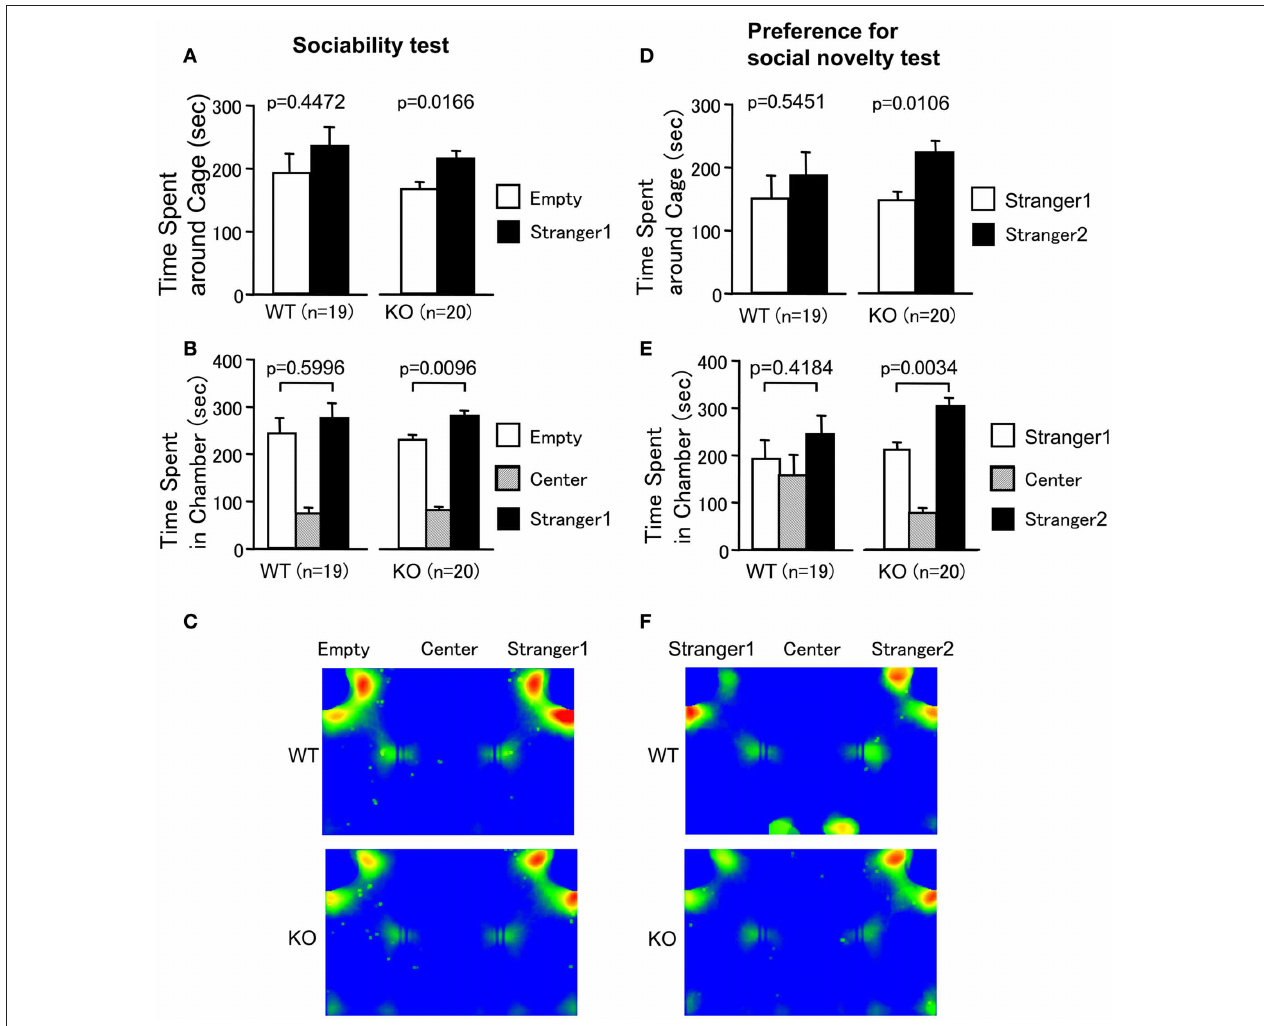
FIGURE 5 | Increased social behaviorof PACAP KO mice in sociability and social novelty preference test. (A–C) Sociability test: the time spent in the vicinity of the empty cage versus the cage containing a stranger (stranger 1) (A) , and the time spent in the chamber with the empty cage, with the cage containing a stranger (stranger 1), and without the cage (center) (B) were shown. (C) All traces of each mouse were superimposed and averaged images for the traces of WT mice (upper C ) and PACAP KO mice (lower C ) in sociability test are shown. (D–F) Preference for social novelty test: the time